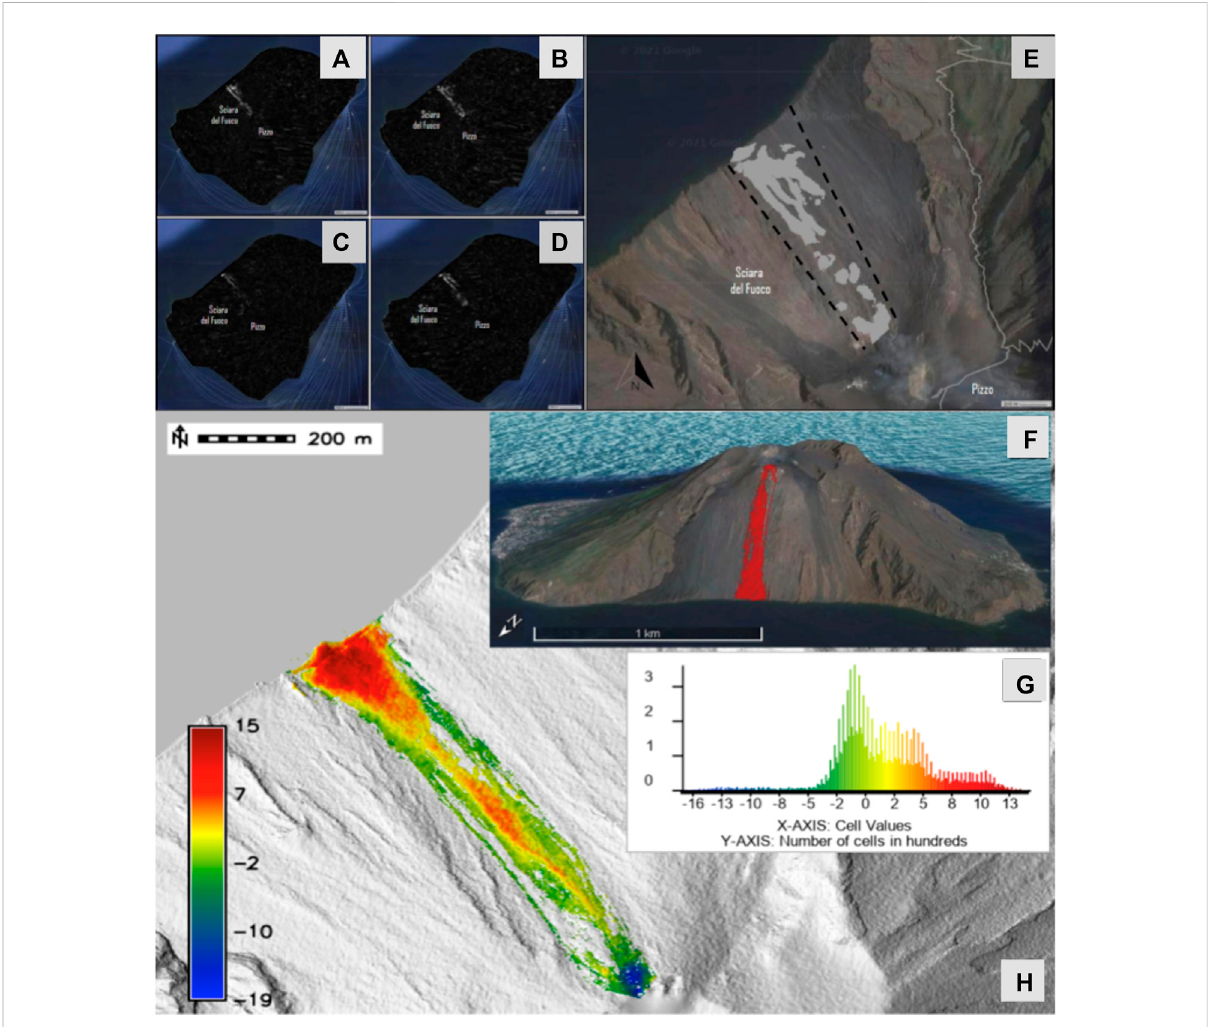
FIGURE 7 Volcanic deposits retrieved from Sentinel-1 SAR amplitude image rationing considering the 16 May 2021 as a pre-eruptive image, and the 22May2021asapost-eruptiveimage.Descendentorbitsareshownin (A) withVV-polarizationand (B) VHpolarization;ascentorbitsareshownin (C) with VV-polarization and (D) VH polarization. Cumulative volcanic deposits are retrieved from the four ratio amplitude images and shown in gray in (E) . The two black dotted lines in (E) mark the boundaries of the deposit. (F) Google Earth view of the Skysat-derived deposits spreading along the Sciara del Fuoco. (G) Thickness distribution of the DEM residuals. (H) 3D mapping of the deposits inside the Skysat-derived area. Colors of the legend represent the deposit thickness in